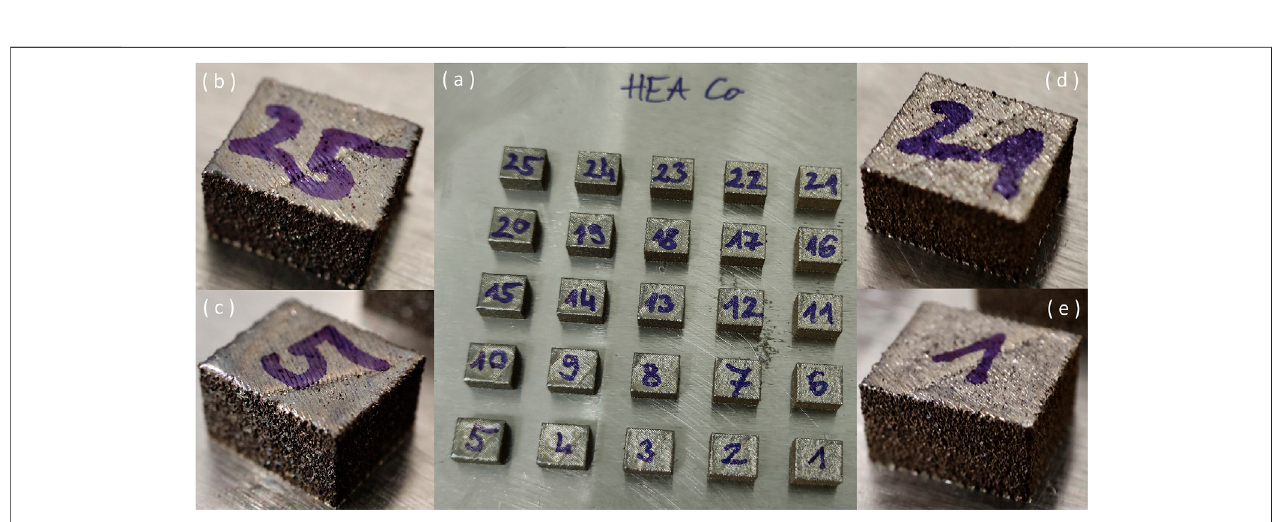
FIGURE 8 | 3D-printed rectangular prisms (A) . 145 [W]; 600 mm/s (B) , 185 [W]; 600 mm/s (C) , 145 [W]; 1,000 mm/s (D) , 185 [W], 1,000 mm/s (E) .